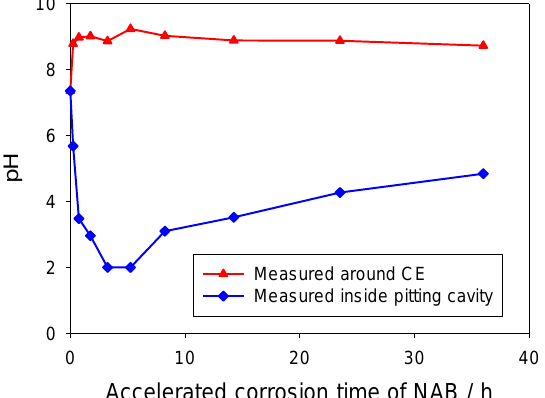
Figure 9. pH changes at pitting cavity site and around counter electrode with accelerated corrosion time at applied potential of +0.730 V for NAB pencil electrode in 3.5% NaCl solution.